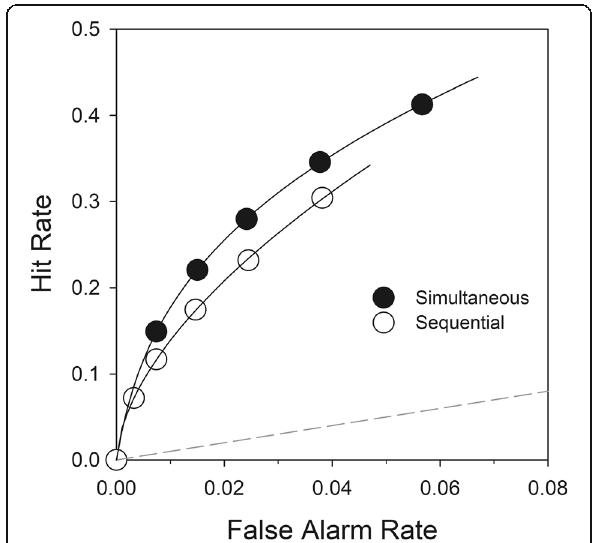
Fig. 6 The same receiver operating characteristic (ROC) data as in Fig. 5 except that the smooth curves generated by a theoretical (signal detection) model are drawn through the ROC data points. The dashed line represents chance performance. To generate these data, d' was set to 1.4 for the simultaneous procedure and to 1.6 for the sequential procedure. The confidence criteria for the simultaneous lineup ranged from 1.5 (the overall decision criterion, c 1 ) to 2.5 (the high-confidence decision criterion, c 5 ). The corresponding confidence criteria for the sequential lineup ranged from 2.0 to 3.0, which captures the widely held view that sequential lineups induce more conservative responding than simultaneous lineups. Finally, criterion variance ( σ C ) was set to 0 for the simultaneous lineup and to 0.75 for the sequential lineup, which is why the sequential lineup, despite its higher d' , yields a lower ROC than the simultaneous